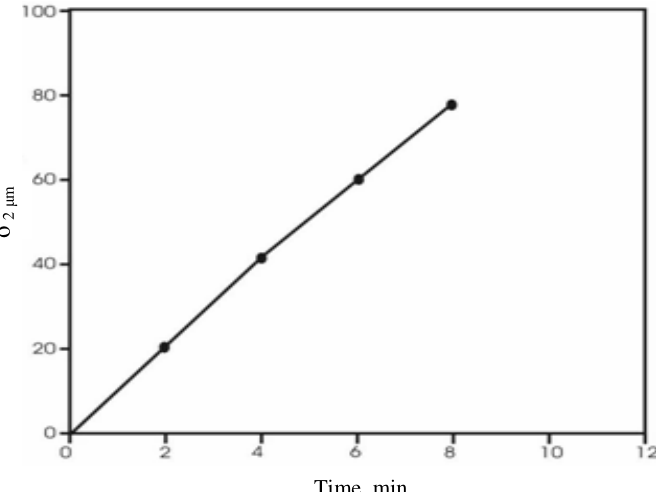
Figure 3. O - production by photosensitized reduction of NBT (1.6 x 10 -4 M in 0.01 M) 2 carbonate buffer with 5-20% DMF, pH 8 using 10 µ g/mL of the p -ADPA (reaction time 12 min.)